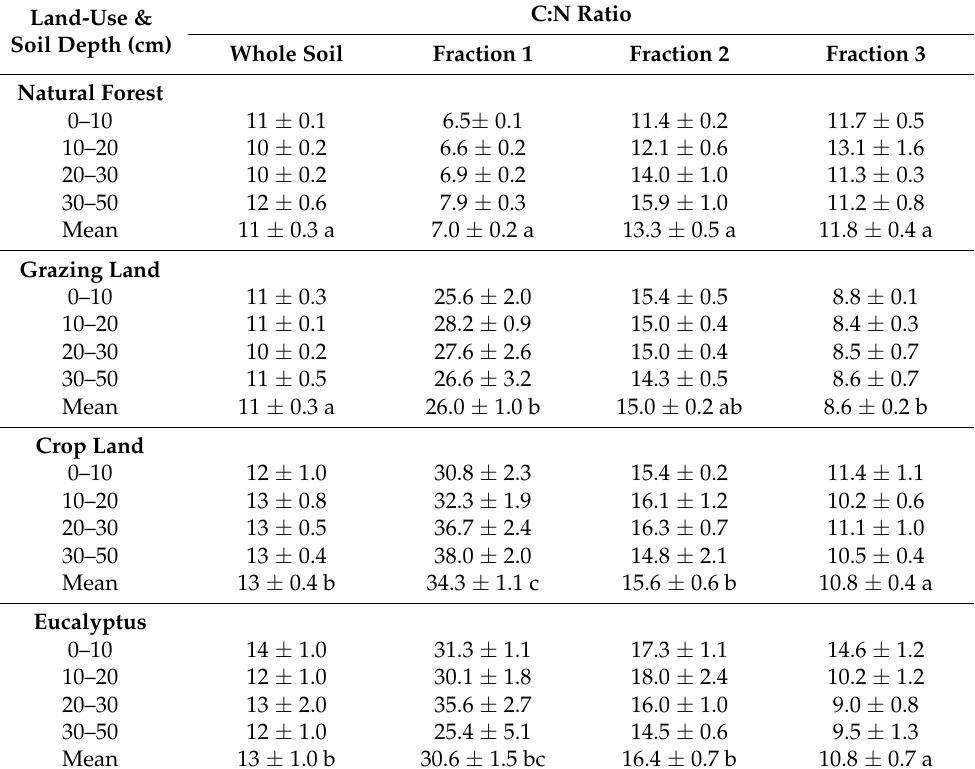
Table 5. C:N ratio of the whole soil and three fractions of SOM (labile 1 and 2 and recalcitrant 3). C:N ratio of 0–50 cm soil profile of each land-use types expressed as mean of four soil layers. Mean C:N ratios ( n = 5, ± SE) without same alphabet along land-use types are statistically significance ( p ≤ 0.05). Land-Use & Soil Depth